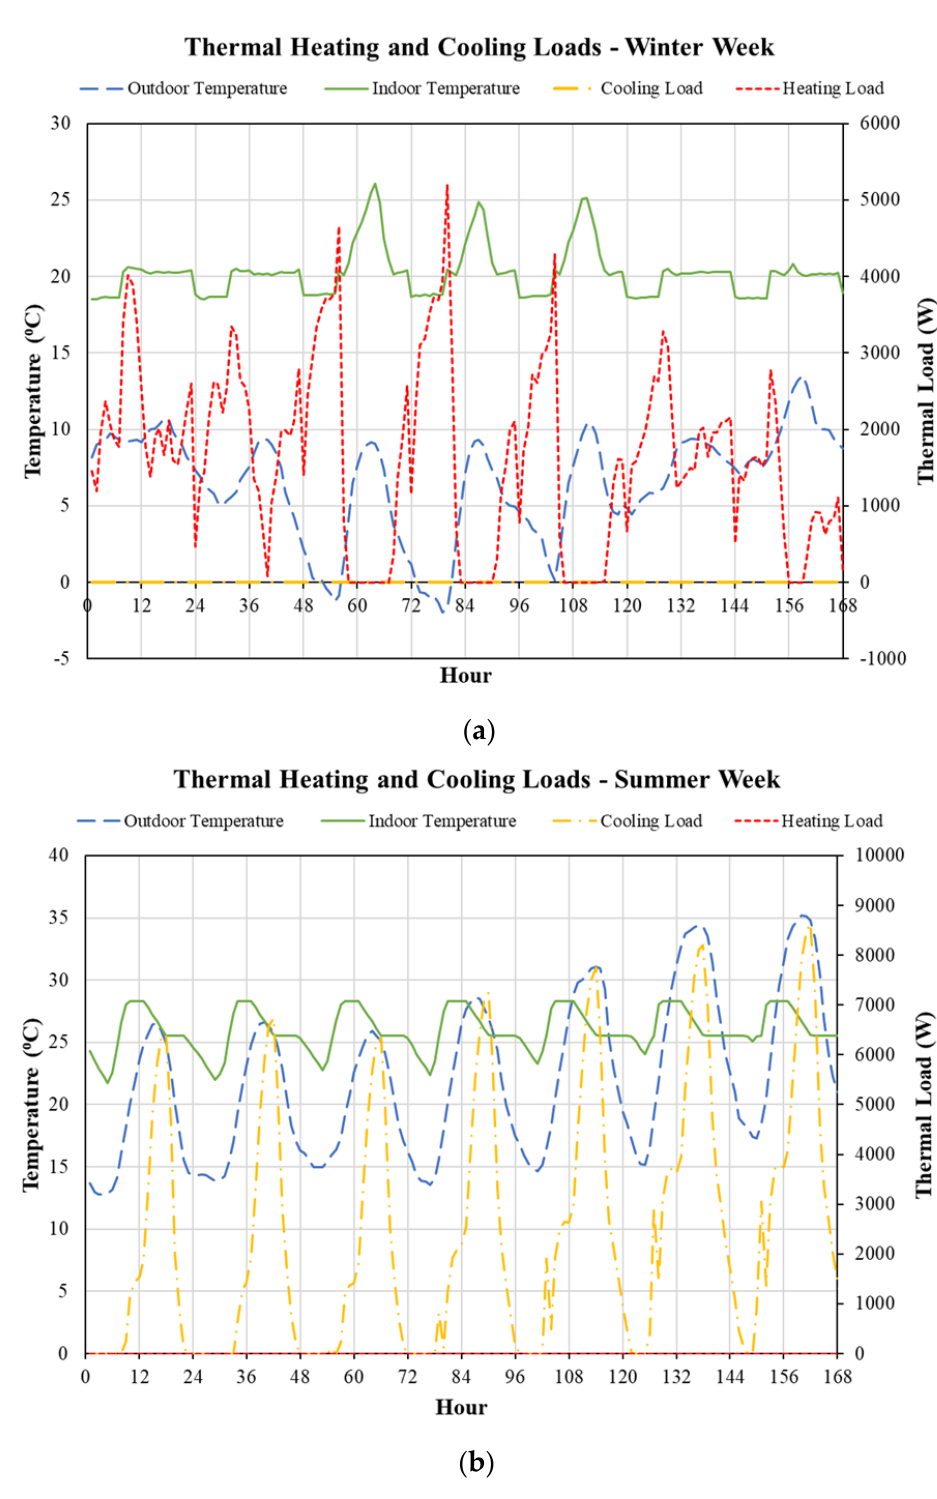
Figure 6. Hourly variations for outdoor and indoor temperatures as well as heating and cooling thermal loads for ( a ) one winter week (i.e., 1 – 7 January) and ( b ) one summer week (i.e., 15 – 22 July) for both baseline and S-GSHP systems for a house in Sacramento.